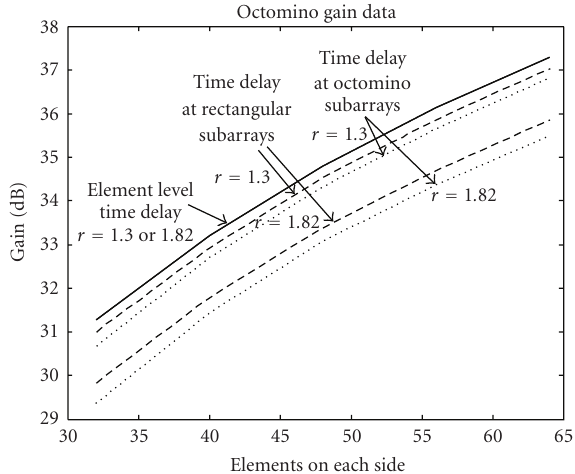
Figure 8: Gain comparison of arrays with time delay at element levels versus time delay at rectangular and L-octomino subarrays r = f/ f = 1.3 and 1.82. 0